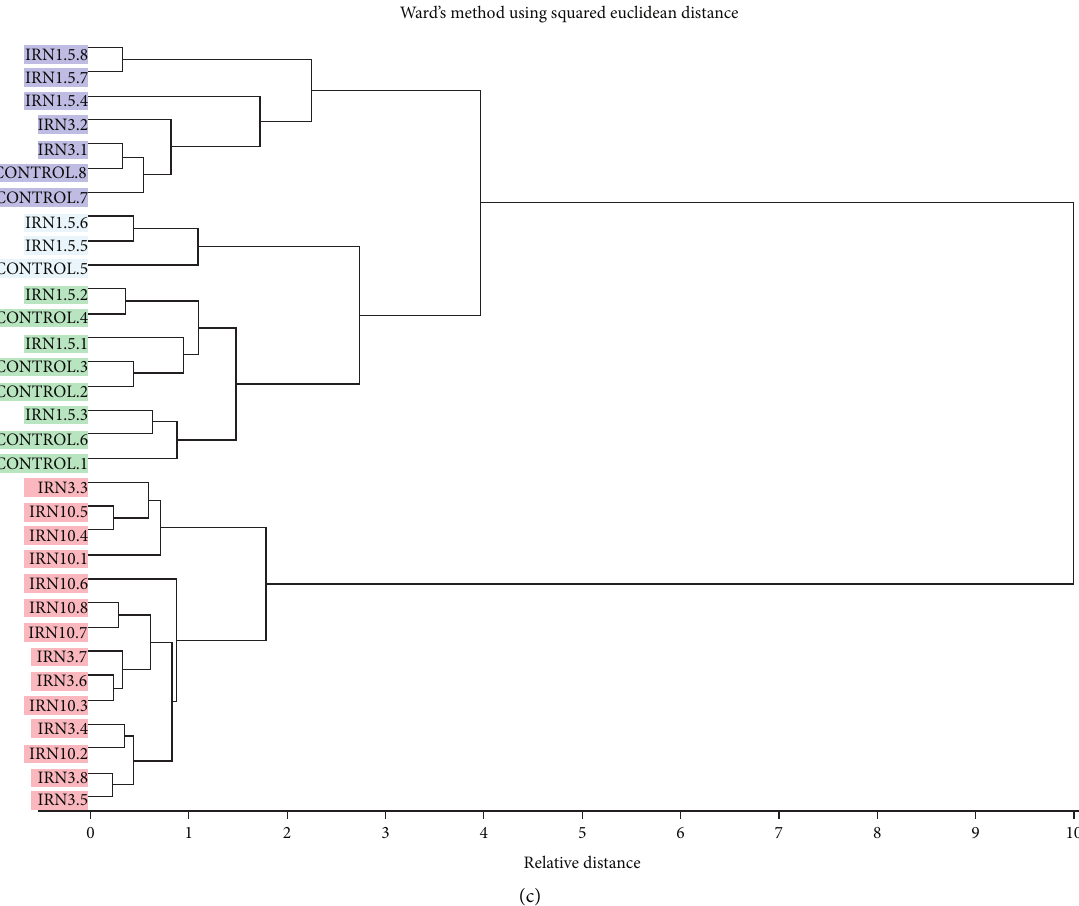
Figure 2: Hierarchical clustering of control and irradiated hazelnut groups using unit vector normalized spectra in the spectral range of (a) 4000–1000cm − 1 , (b) 3050–2800cm − 1 , and (c) 1800–1000cm − 1